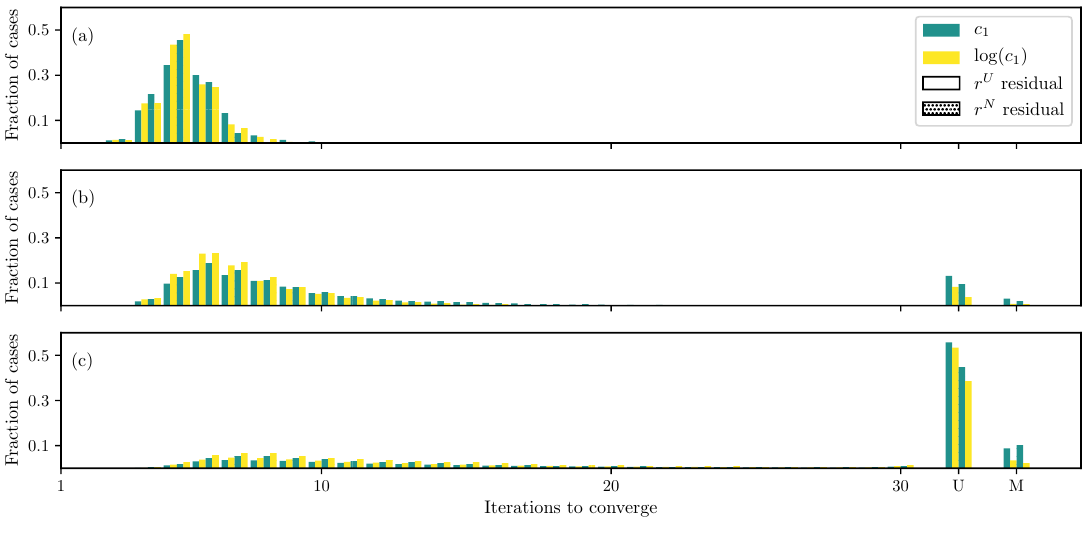
Figure 1. Iterations required using different formulations for GOH model (2) displacement controlled (DC) case when ( a ) only c 1 and c 2 are unknown, ( b ) all parameters except the angle θ are unknown, and ( c ) all parameters are unknown.